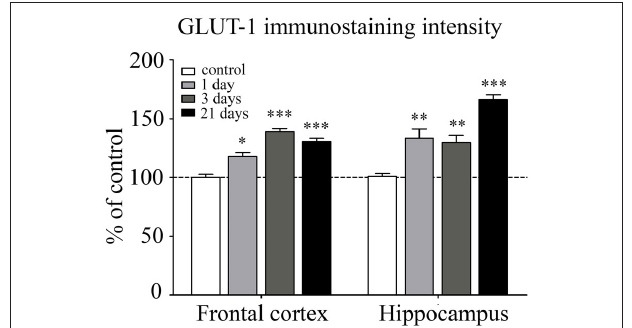
FIGURE 7 | Analysis of GLUT-1 immunofluorescence pattern in the frontal cortex and hippocampus of rats following restraint stress. The graph represents the fluorescence intensity of the immunostaining. Results are expressed as percentages of the unstressed control group. Values for each group are means ± SEM. Data were analyzed by One-way ANOVA followed by Kruskal–Wallis test and Dunn’s multiple comparison tests. * p < 0.05 , ** p < 0.01 and *** p < 0.001 , significant differences as compared to the unstressed control